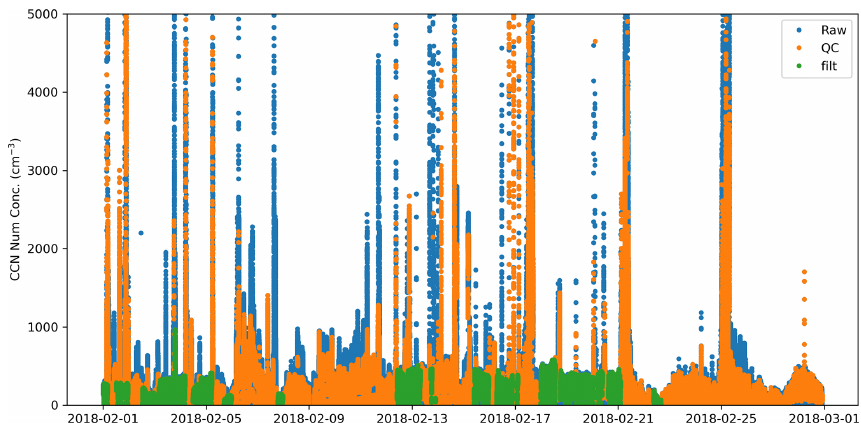
Figure A2. Exhaust contamination of CCN 0 . 5 data from February 2018 of the MARCUS voyage, showing the amount of data remaining after quality control (orange) and the subsequent removal of exhaust contaminated data (green).